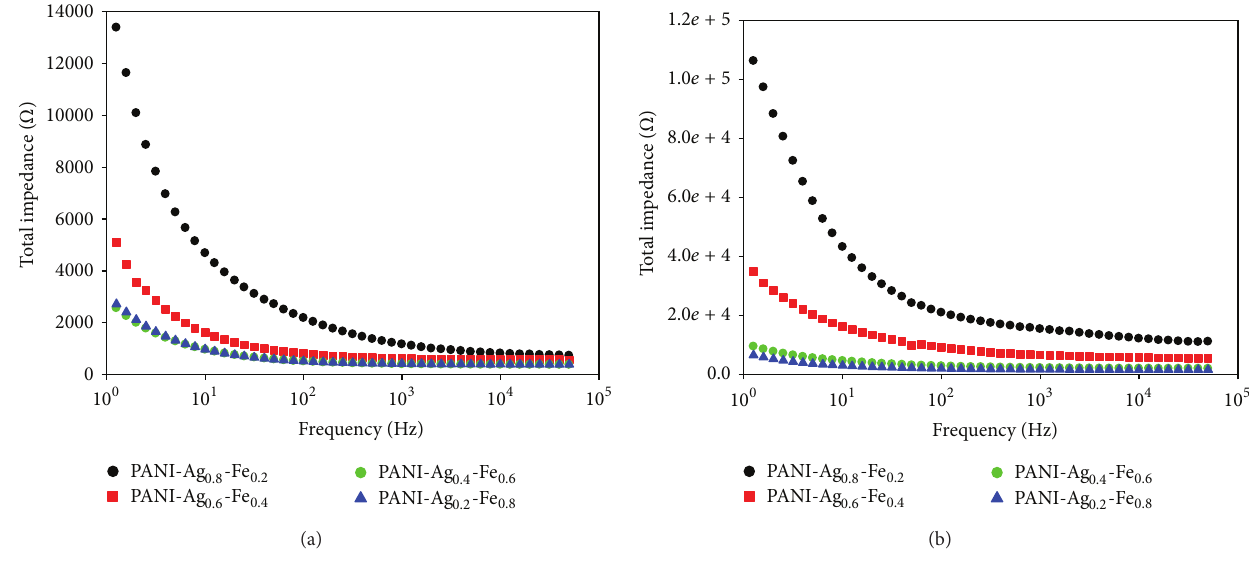
Figure 9: Total impedance versus frequency plots when incubated in E. coli solution for PANI-Ag-Fe nanocomposite thin films (a) before annealing and (b) after annealing at 300 ∘